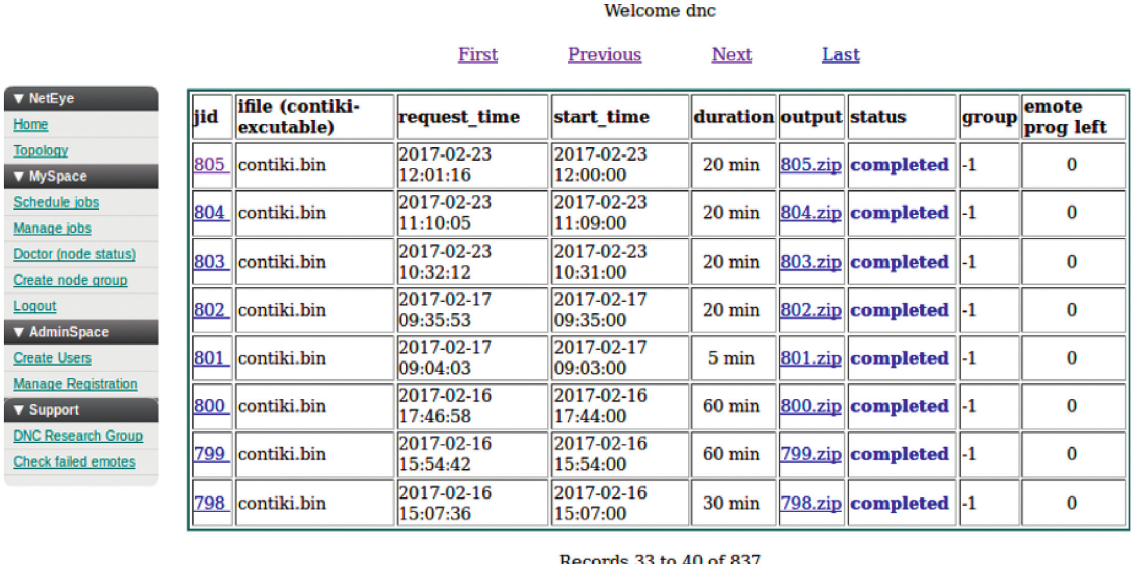
Figure 5: Server management interface